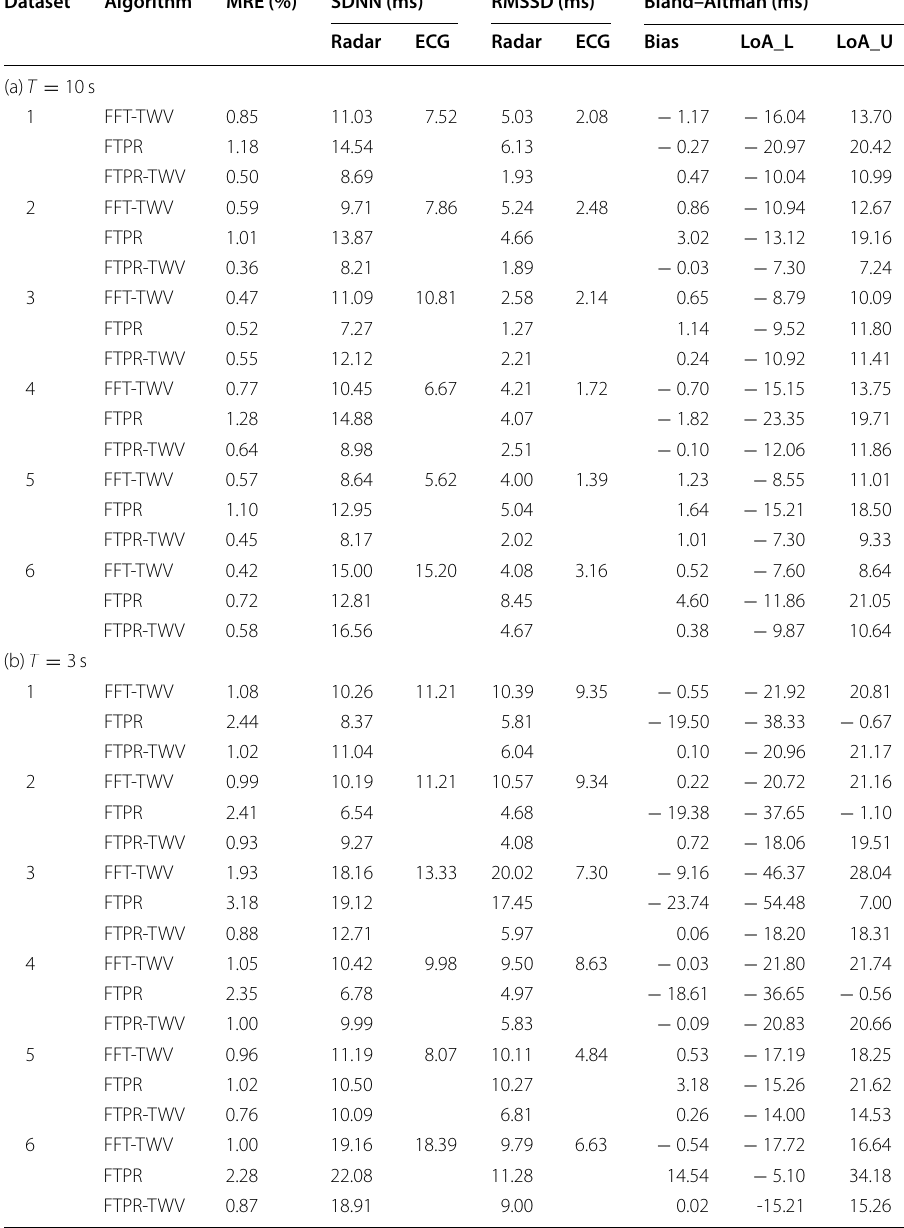
Table 4 HRV estimation results analysis